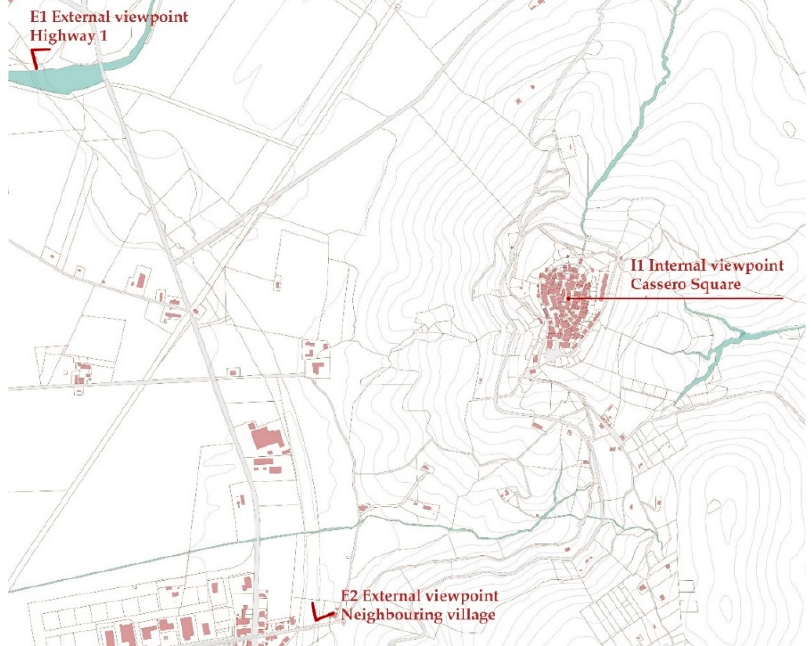
Figure 4. Significant internal and external observation points.